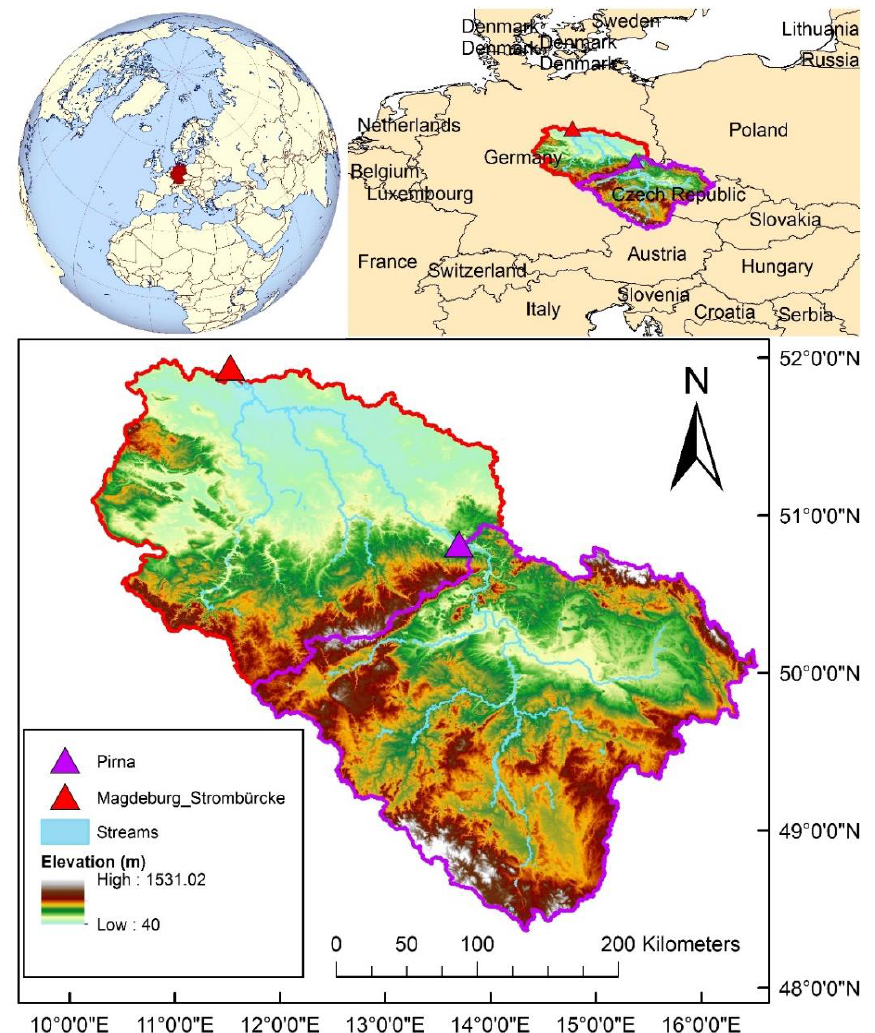
Figure 1. Location and catchment area of the Pirna and Magdeburg-Strombrücke gauging stations © Khan.